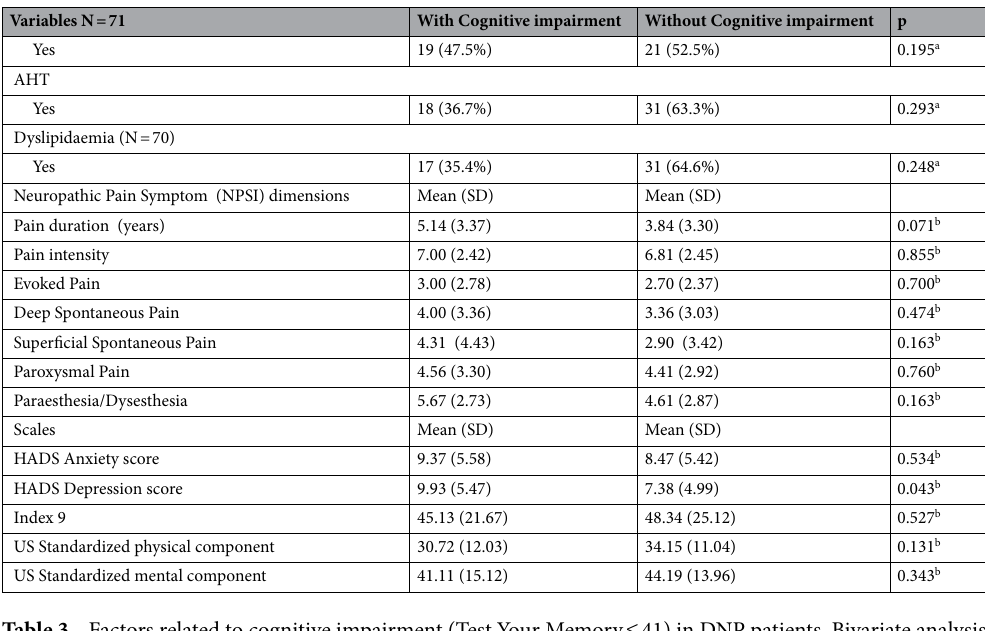
Table 3. Factors related to cognitive impairment (Test Your Memory ≤ 41) in DNP patients. Bivariate analysis. a Pearson’s chi-squared. b Mann–Whitney. c Likelihood ratio; SD = Standard Deviation; BMI = Body Mass Index; AHT = Arterial hypertension.